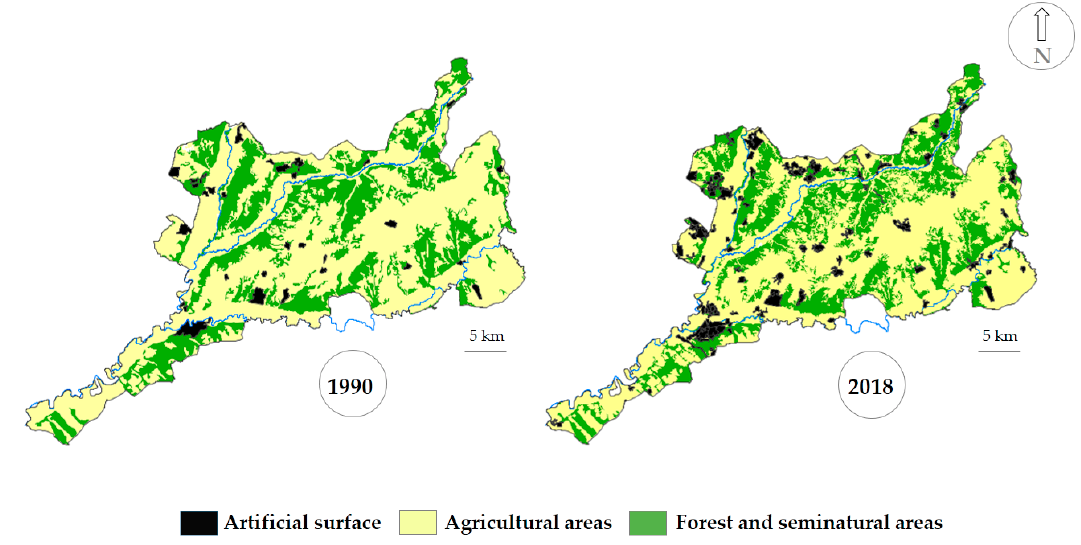
Figure 6. Land-use changes between 1990 and 2018 in the Comarca de las Vegas. Table 4. Changes between 1990 and 2018.